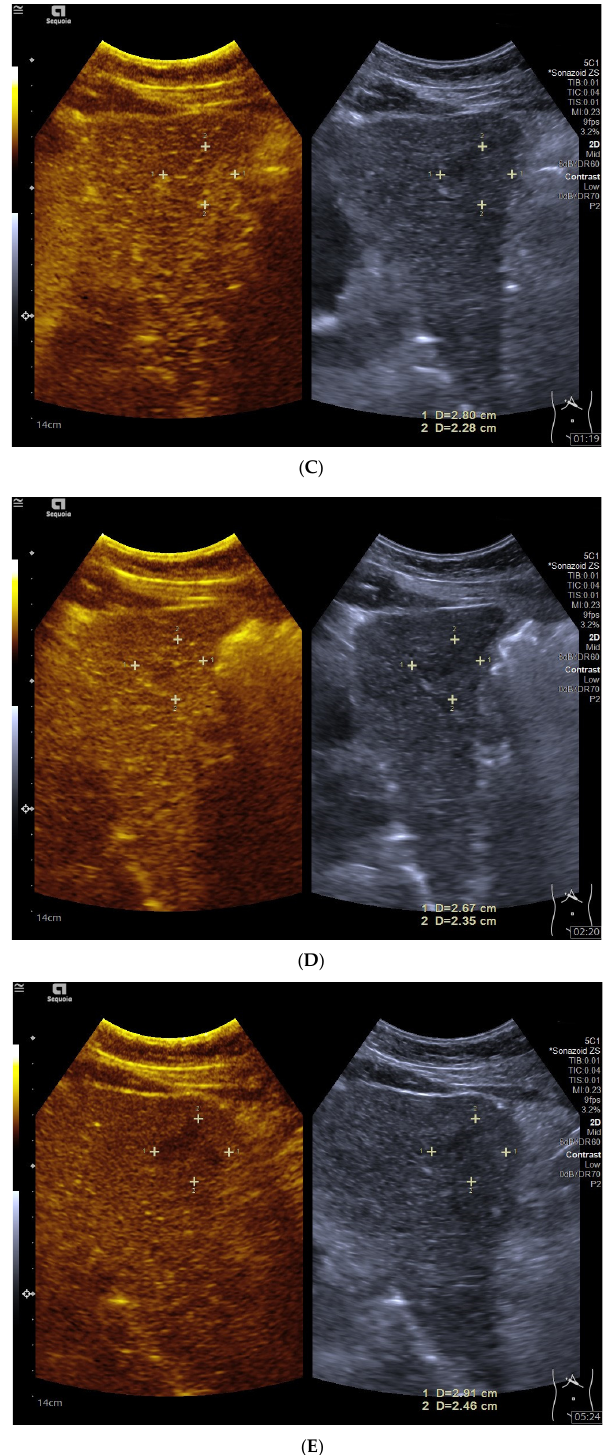
Figure 2. Hepatocellular carcinoma in liver cirrhosis in a 58-year-old male patient. B-mode ultrasound (BMUS) showed a hypoechoic lesion with an ill-defined margin and irregular shape in the left lobe of the liver with cirrhosis ( A ). After injection of Sonazoid, the lesion displayed heterogeneous hyperenhancement during the arterial phase ( B ) and isoenhancement during the portal venous phase ( C ) and late phase ( D ). The lesion showed late washout (264 s after the injection of Sonazoid) and hypoenhancement in the Kupffer phase ( E ). During the late phase and the Kupffer phase, all HCC lesions in the non-cirrhotic liver (100%, 19/19) showed hypoenhancement. Five cases of HCC lesions in liver cirrhosis showed isoenhancement in the late phase (13.9%, 5/36) and hypoenhancement in the Kup- ffer phase. The rest of the cirrhotic HCC lesions showed hypoenhancement during the late phase and the Kupffer phase (86.1%, 31/36) (Table 3). In the Kupffer phase, 15 additional hypoenhanced FLLs were detected in three patients in the non-cirrhosis liver group and in eight patients in the liver cirrhosis group, which were also suspected to be HCC lesions. The mean size of these lesions was 13.0 ± 5.6 mm (ranging from 5 to 25 mm). The mean depth to the liver capsule was 22.3 ± 3.9 mm (ranging from 15 to 28 mm). All the additional lesions showed as isoechoic (100%, 15/15) on BMUS.